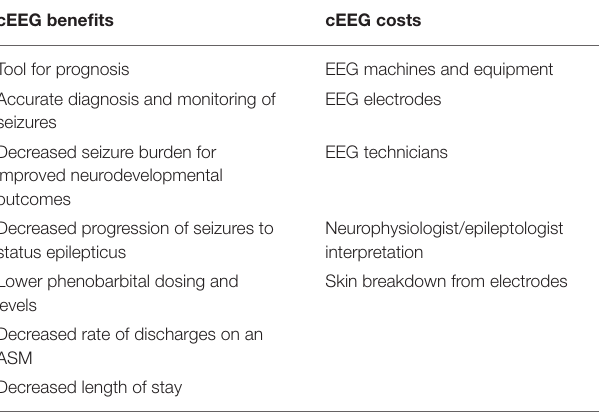
TABLE 3 | Benefits and costs of cEEG.